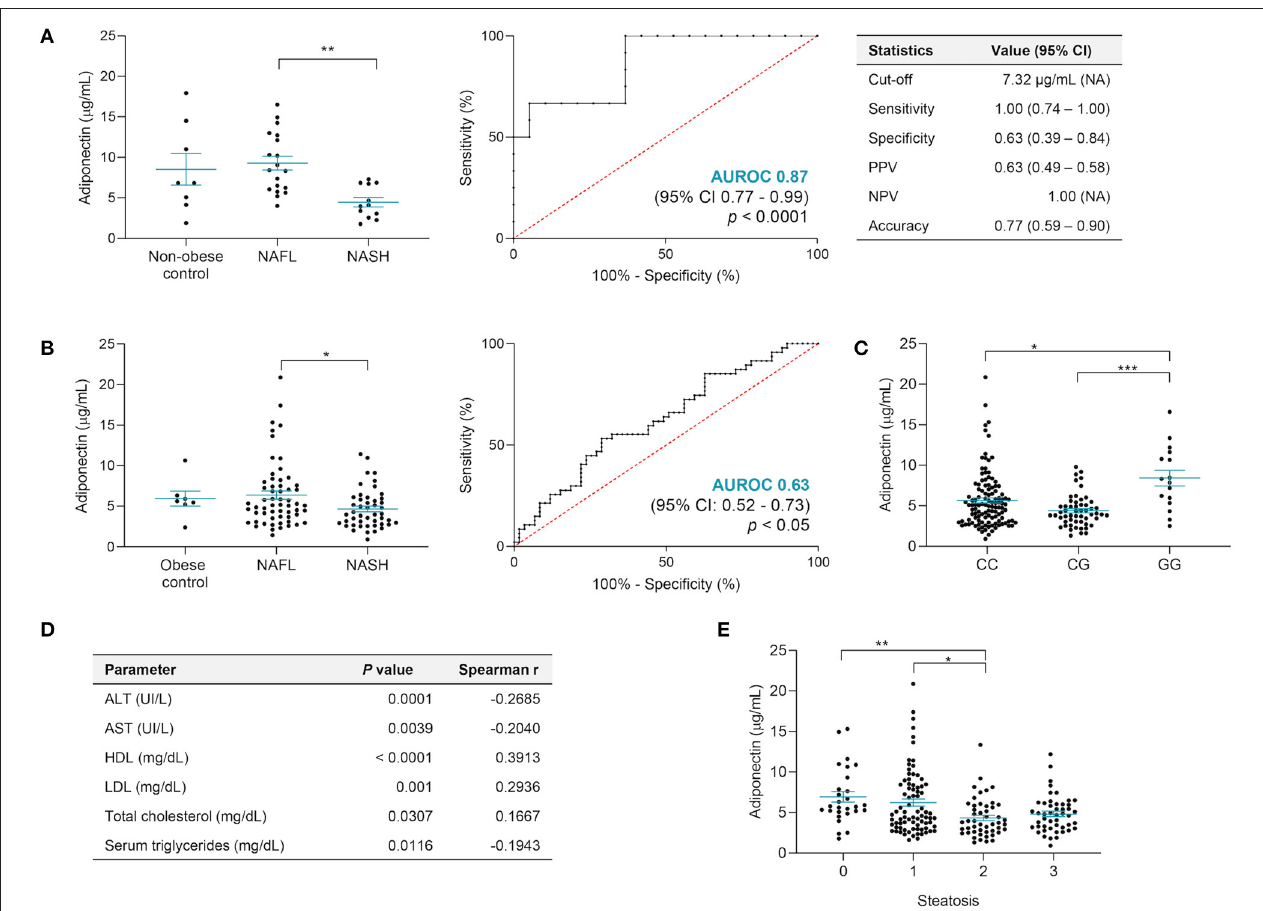
FIGURE 3 | Adiponectin serum levels differentiate NAFL and NASH, but PNPLA3 genotype may be a confounding factor. (A) In the discovery cohort, the adiponectin serum levels were significantly lower in NASH when compared to NAFL, presenting an AUROC value of 0.87 and very high sensitivity and NPV (non-obese control, n = 8; NAFL, n = 19; NASH, n = 12). (B) In the validation cohort, adiponectin distinguishes NAFL from NASH only within PNPLA3 CC allele carriers, with an AUROC value superior to 0.6 obese controls, n = 7; NAFL, n = 59, NASH, n = 47). (C) In the validation cohort, NAFLD patients with PNPLA3 GG genotype also showed increased levels of adiponectin. The x -axis represents the three possible genotypes for rs738409 polymorphism: CC allele, n = 117; CG allele, n = 55; GG allele, n = 16). (D) Correlations between adiponectin serum levels and several parameters: AST and ALT serum levels (both n = 199), HDL and LDL serum levels (both n = 167), total cholesterol levels ( n = 168), and triglyceride serum levels ( n = 168). (E) The adiponectin levels decreased with higher grades of steatosis. The x -axis represents the histological grade of steatosis, ranging from 0 to 3. There was a significant difference between grade 2 vs. grade 1 and vs. grade 0 ( n = 28, grade 0; n = 80, grade 1; n = 49, grade 2; n = 48, grade 3). Adiponectin levels depicted as mean ± SEM. ALT, alanine aminotransferase; AST, aspartate aminotransferase; CI, confidence interval; HDL, high-density lipoprotein; LDL, low-density lipoprotein; NAFL, non-alcoholic fatty liver; NASH, non-alcoholic steatohepatitis. * p < 0.05; ** p < 0.01; *** p < 0.001.